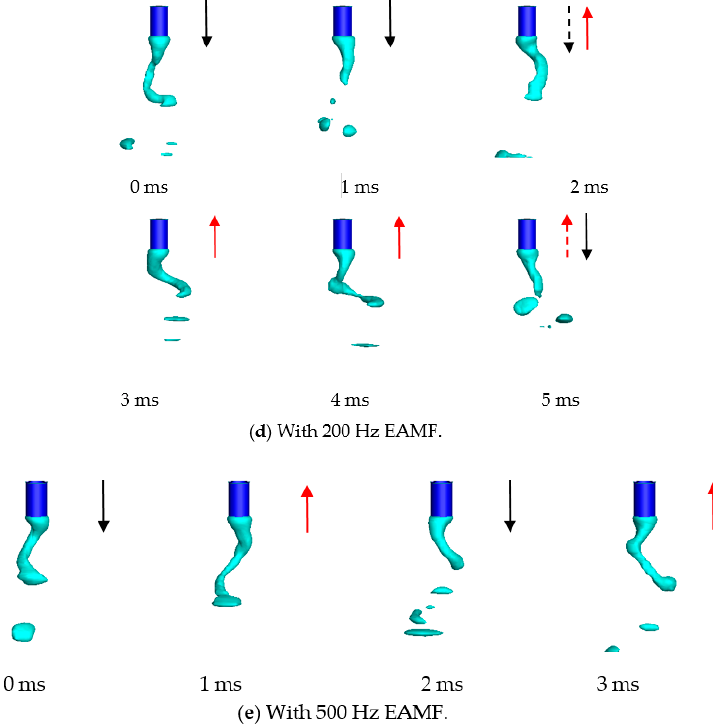
Figure 9. High-current GMAW metal transfer under the influence of EAMFs at different alternating frequencies.